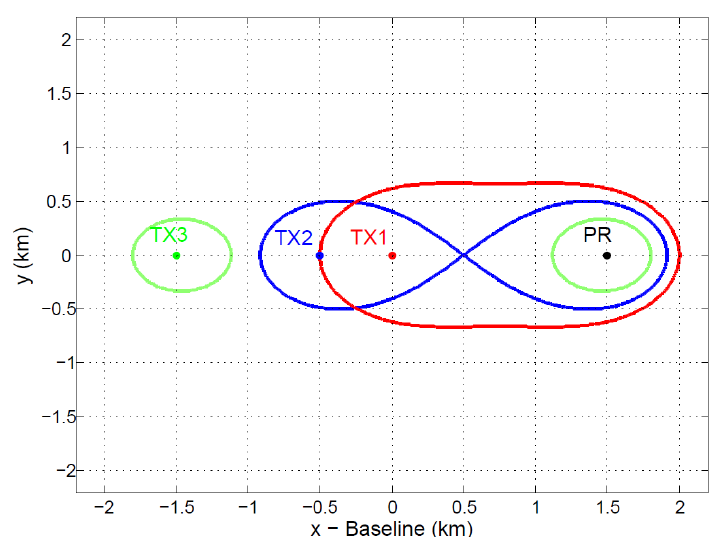
Figure 7. Study of different coverage areas for a fixed passive radar (PR) position as a function L/ ( R in blue and L/ ( R